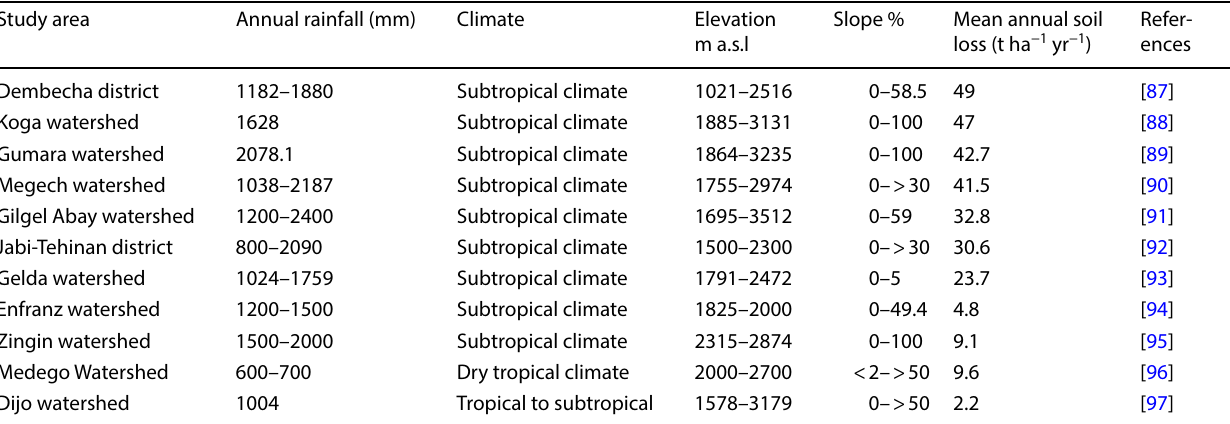
Table 10 Soil loss estimation conducted in highlands of Ethiopia Study